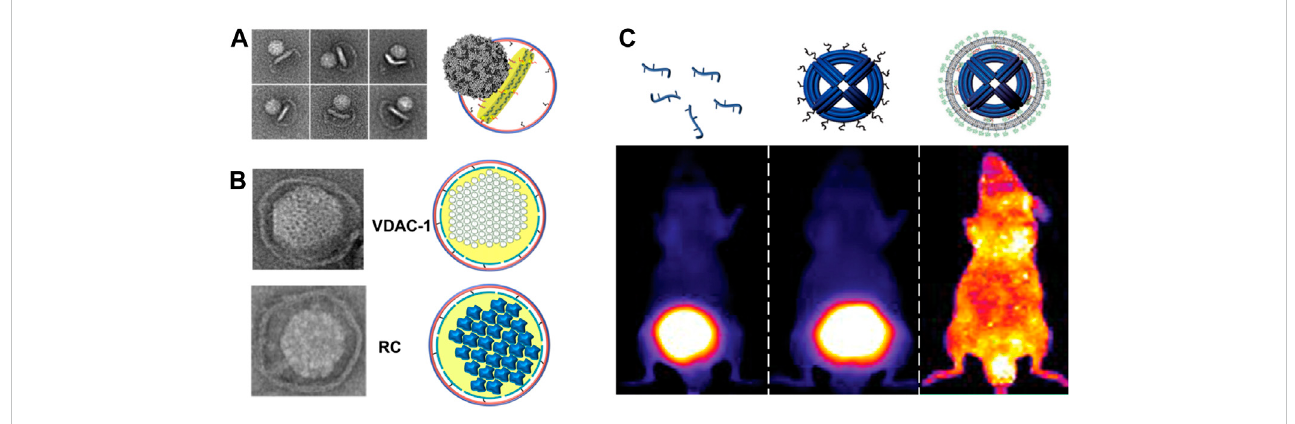
FIGURE 4 (A) Binding and interactions of poliovirus with CD155 -decorated DNA-corralled nanodiscs (DCNDs). TEM images showing individual viral particles tetheredtoDCNDs.Someimagesshowthebendingofthebilayerbythepoliovirus( fi gureusedwithpermissionfromZhaoetal.,2018). (B) DCNDswereused to reconstitute human voltage-dependent anion channel 1 (hVDAC1) and Rhodobacter sphaeroides photosynthetic reaction center (RC) protein clusters ( fi gure used with permission from Zhao et al., 2018). (C) Encapsulation of DNA origami within lipid bilayers achieves better in vivo stability (protection against nucleases digestion) and bio-distribution. Fluorescent images of mice showing the bio-distribution of Alexa-Fluor750-labeled oligonucleotide, DNA origami, and encapsulated DNA origami inside lipid bilayers ( fi gure used with permission from Perrault and Shih